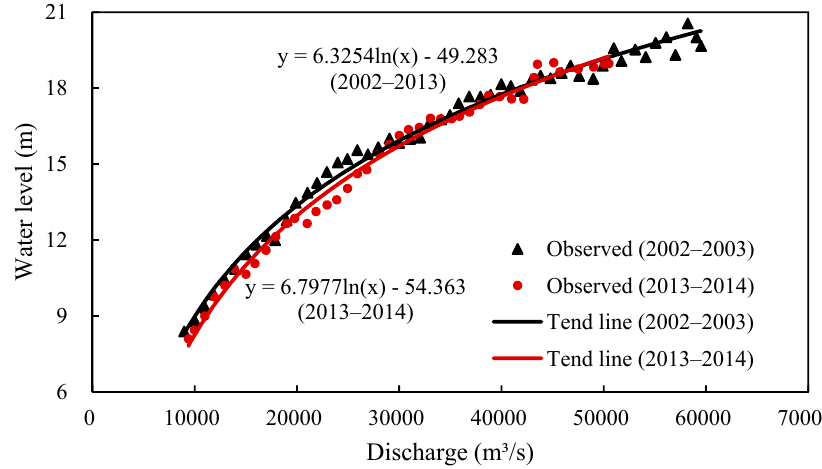
y = 6.3254ln(x) - 49.283